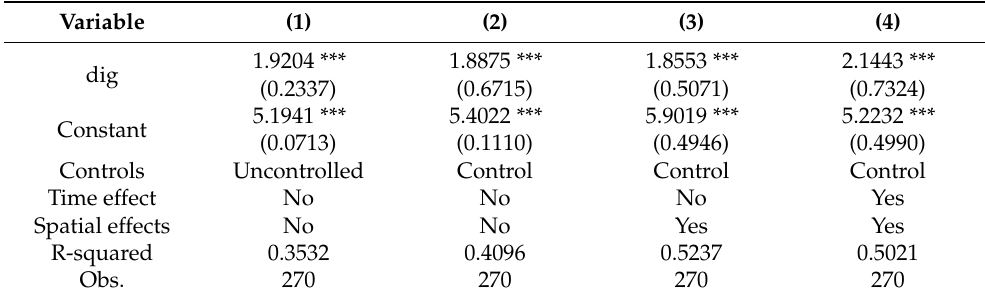
Table 4. Panel model regression